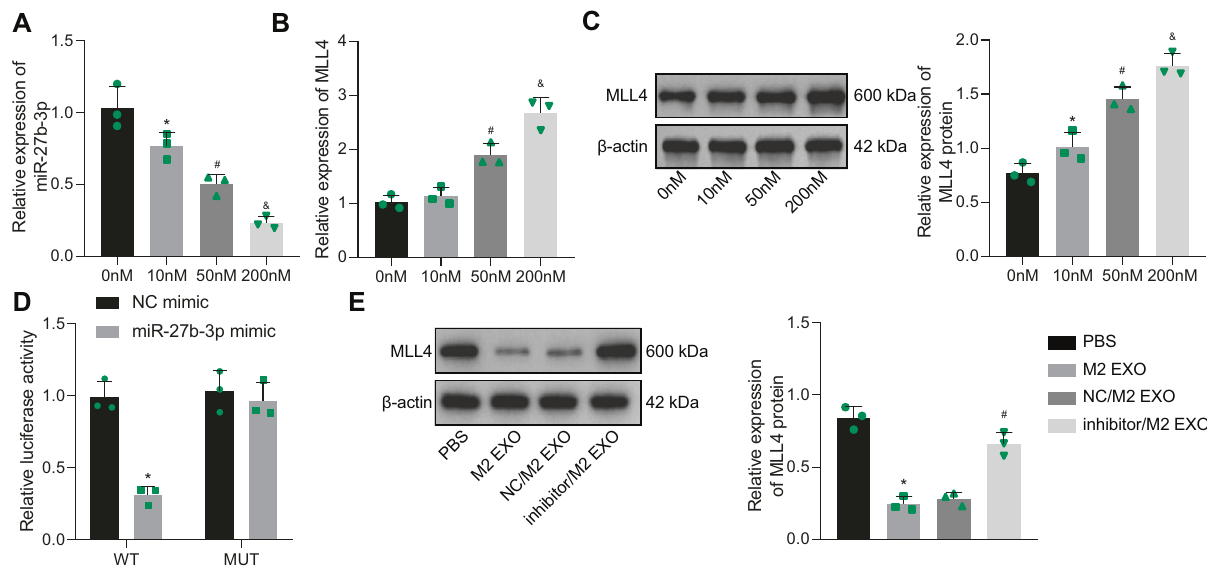
Fig. 5 miR-27b-3p targets MLL4 and downregulates its expression. A After GSCs were treated with miR-27b-3p inhibitor (0, 10, 50, and 200 nM), the expression of miR-27b-3p in GSCs was determined by RT-qPCR. B After GSCs were treated with miR-27b-3p inhibitor (0, 10, 50, and 200 nM), the expression of MLL4 in GSCs was tested by RT-qPCR. C After GSCs were treated with miR-27b-3p inhibitor (0, 10, 50, and 200 nM), the protein expression of MLL4 in GSCs was measured by Western blot analysis. D The binding of miR-27b-3p to MLL4 tested by dual luciferase reporter assay. E After co-culture of GSCs with M2-TAM-derived exosomes or exosomes derived from miR-27b-3p inhibitor-treated M2-TAMs, the expression of MLL4 in GSCs as measured by western bot analysis. * p < 0.05 vs. the 0 nM group, the NC mimic group, or the PBS group. # p < 0.05 vs. the 10 nM group or the M2 EXO group. & p < 0.05 vs. the 50 nM group. Measurement data were depicted as mean ± standard deviation. Comparison of data between two groups was conducted by unpaired t test, while that among multiple groups by one- way ANOVA followed by Tukey ’ s post hoc test. Cell experiments were repeated three times